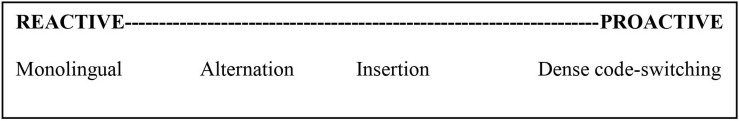
Reactive-proactive control continuum.